Question: Identify the chart type used in this figure.
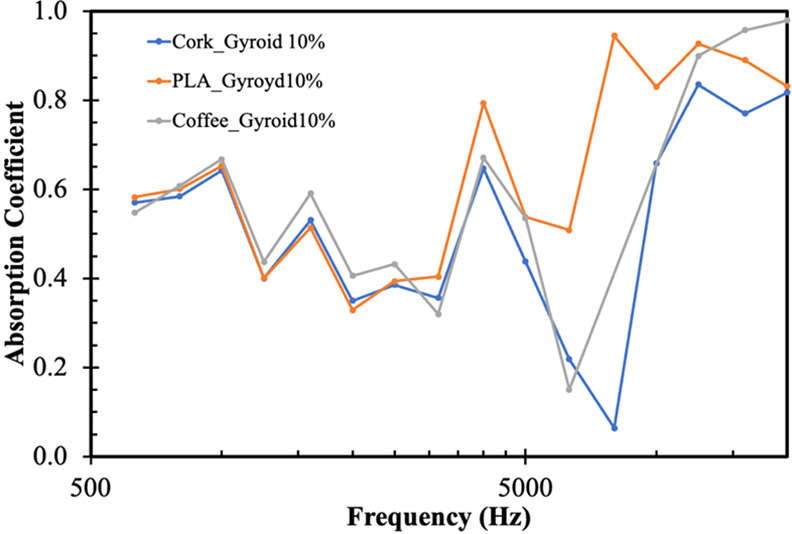
Answer: line